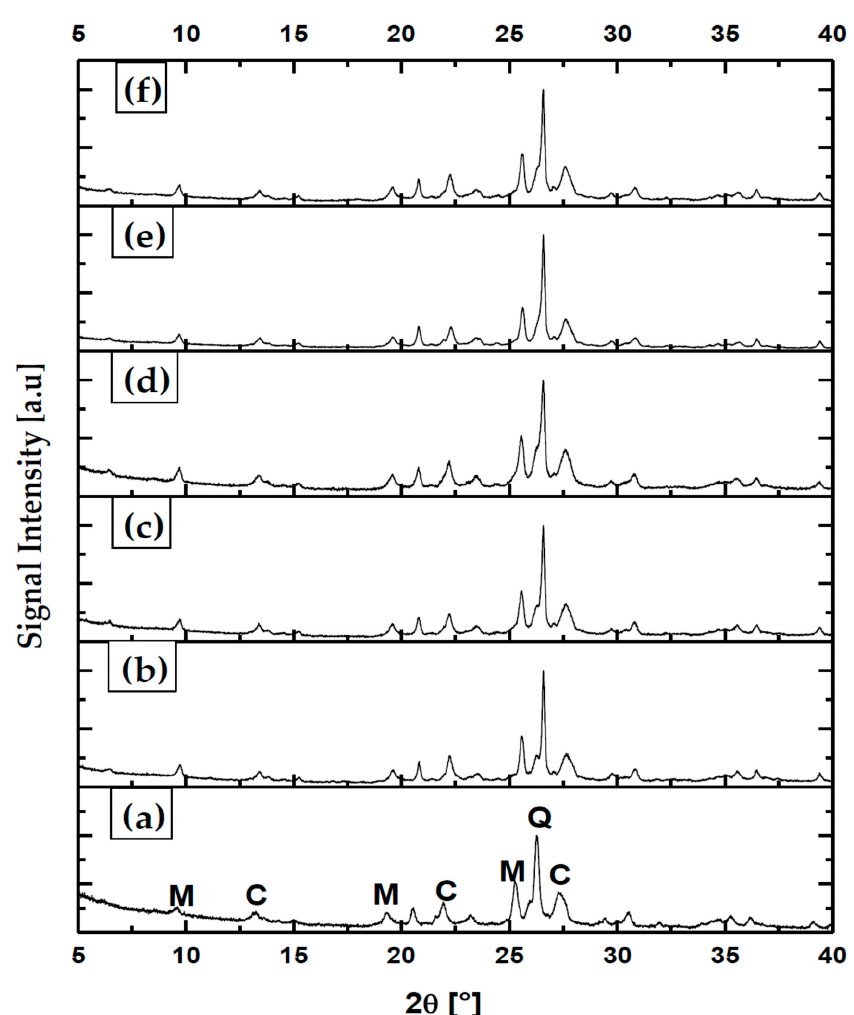
Figure 5. XRD to samples of natural zeolite. ( a ) Z without grinding; ( b ) Z first grinding; ( c ) Z second grinding; ( d ) nZ; ( e ) nZH; ( f ) nZH-Cu.